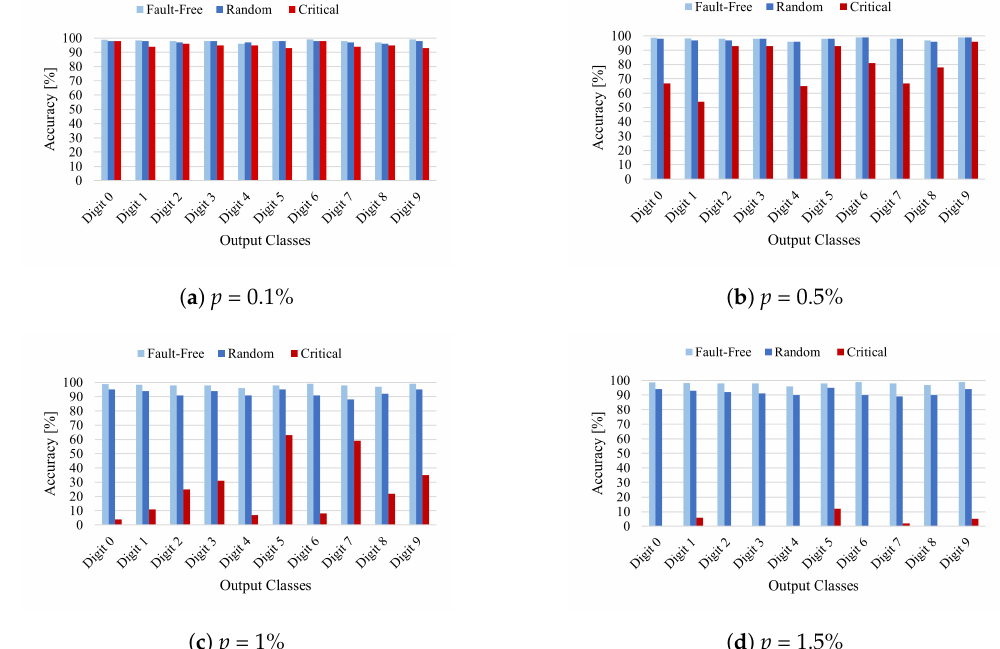
Figure 4. MNIST LeNet: software fault injection campaigns on random and critical neurons. A fixed percentage p of neurons is